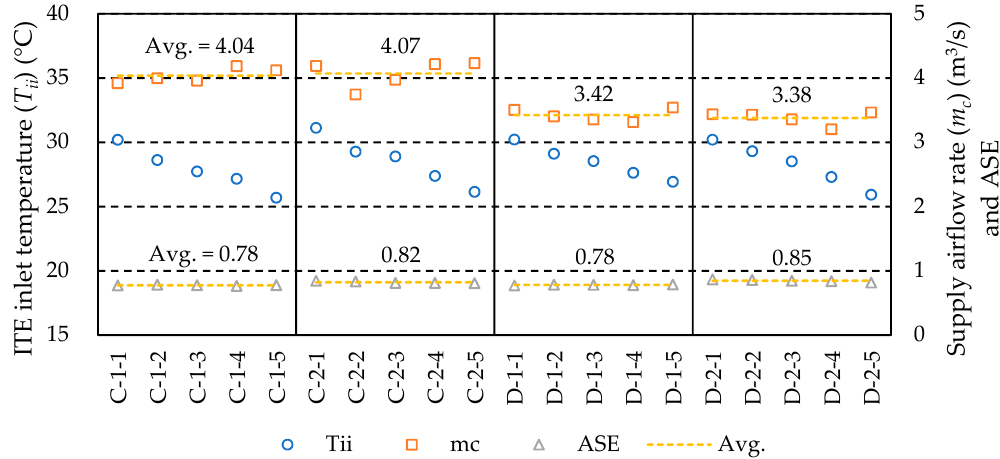
Figure 11. Information-technology equipment (ITE) inlet temperature ( T ii ), supply airflow rate ( m c ), and air-segregation efficiency (ASE) for each experimental condition.